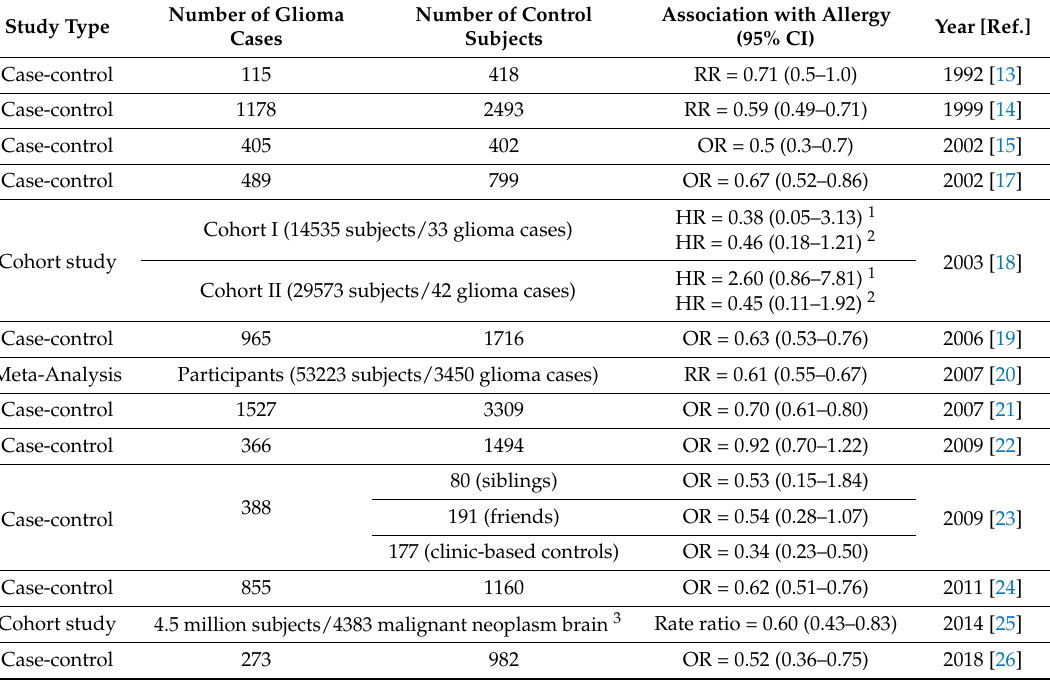
Table 1. Epidemiological studies of allergy and risk of